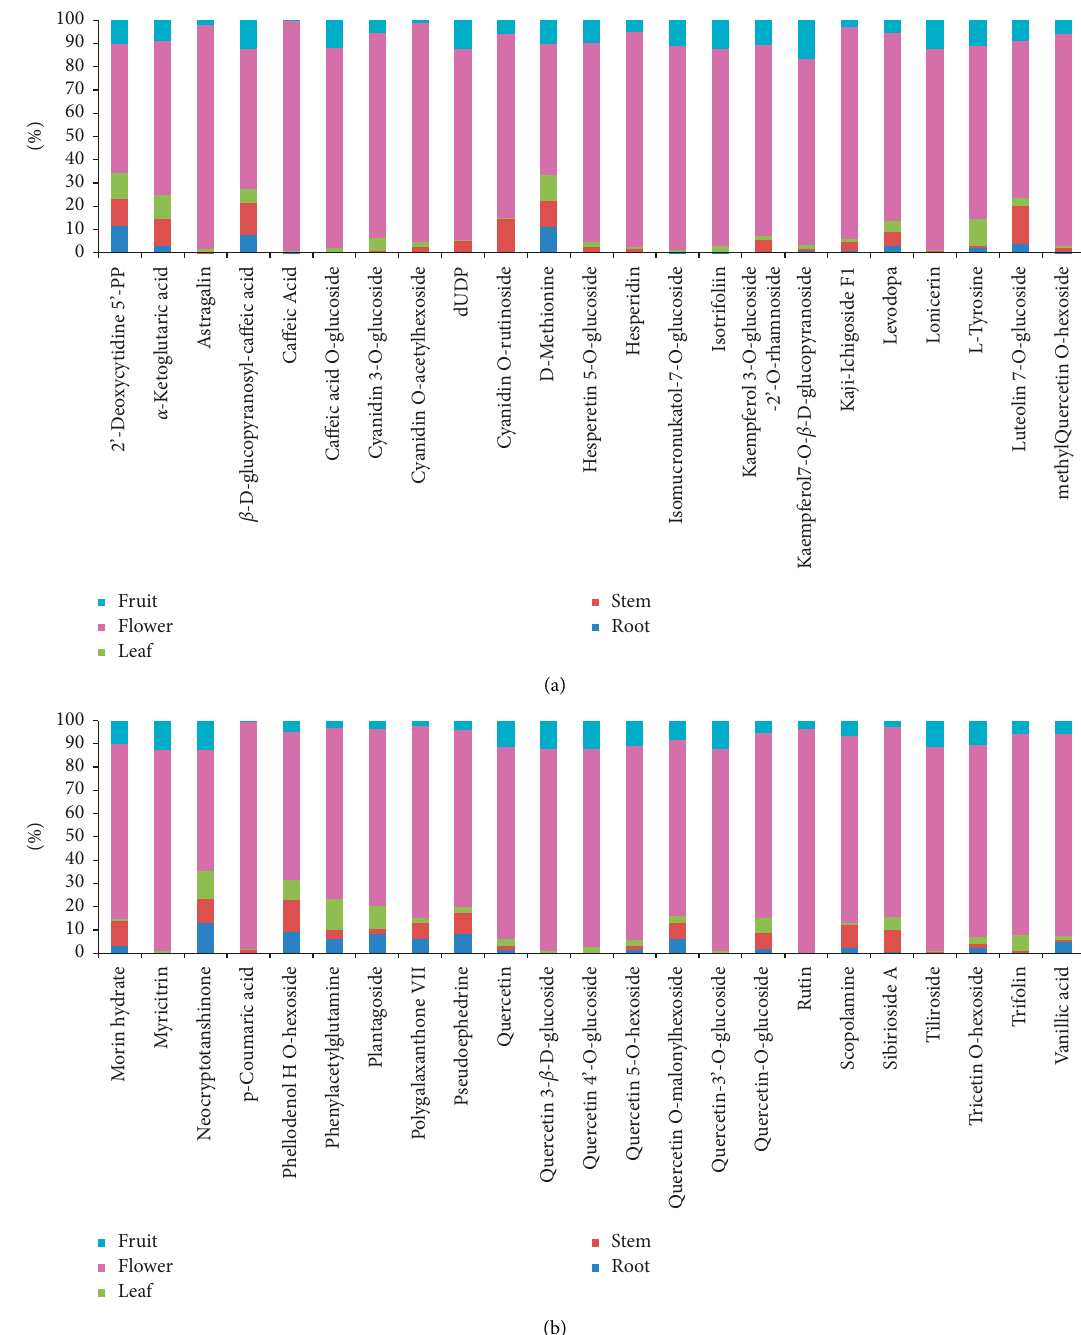
Figure 4: Significantly highly accumulated metabolites in flower compared to root, stem, leaf, and fruit. Each of Log (Flower/Stem), Log 2 (Flower/Leaf), Log 2 (Flower/Fruit) of the 46 components were more than